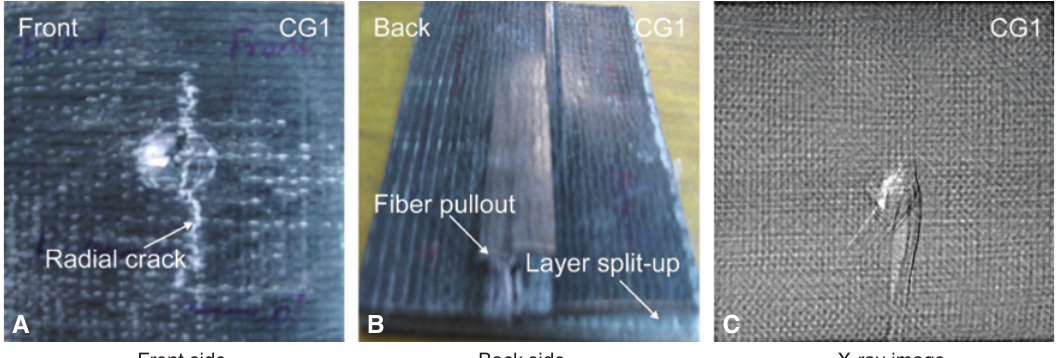
Figure 8: Photographs of impacted specimen